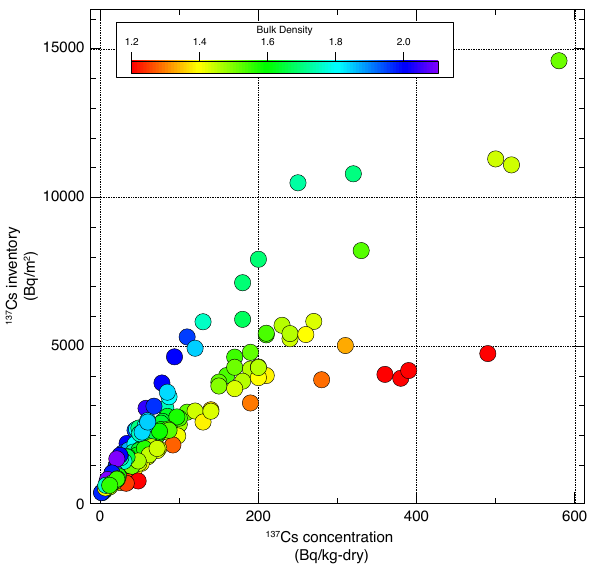
Fig. 9. Variation of 137 Cs concentrations with sediment bulk density at the sampling stations shown in Fig.